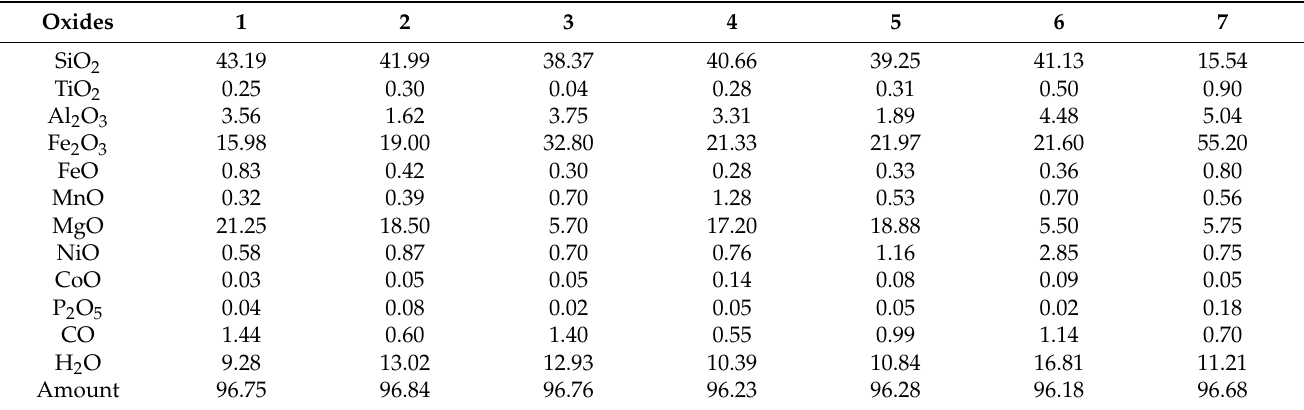
Table 1. The chemical composition of the weathering crust of the Kempirsay ultramafite massif 1